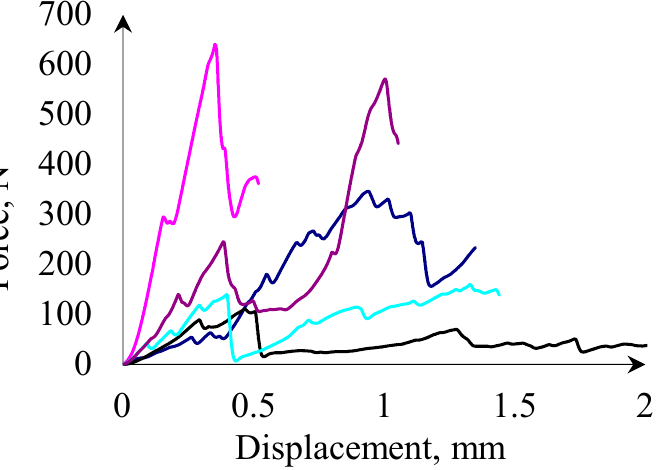
Figure 6. Example results of the compression test for five corn grains from 100 tested.